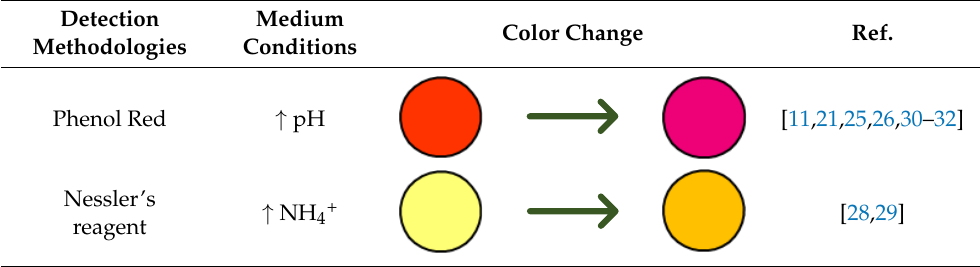
Table 2. Colorimetric ASNase-based biosensors: detection methodologies, medium conditions and color change.